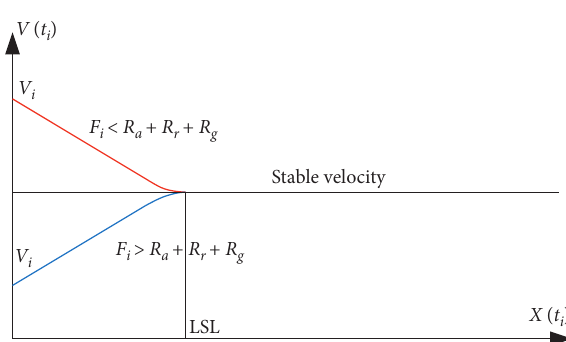
Figure 2: Schematic diagram of the dynamic motion